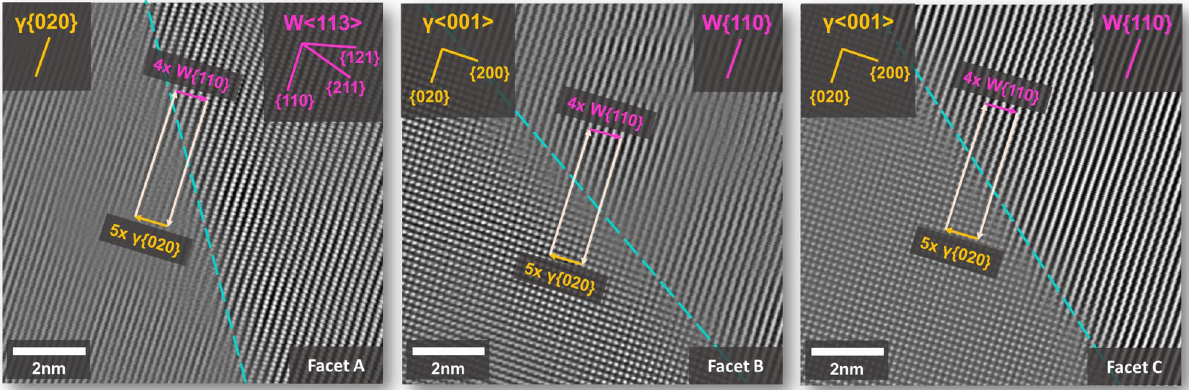
Figure 3. Atomic column images of facets A, B, and C shown in Fig. 2. Each region has been mapped, providing crystallographic planes and directions in the BCC W and FCC γ-phase regions on either side of the IPB. It is evident that for each facet the W{110} is parallel to the γ{200}. For each boundary, a Burgers circuit has been drawn highlighting that regardless of the physical boundary plane, the lattice matching remains